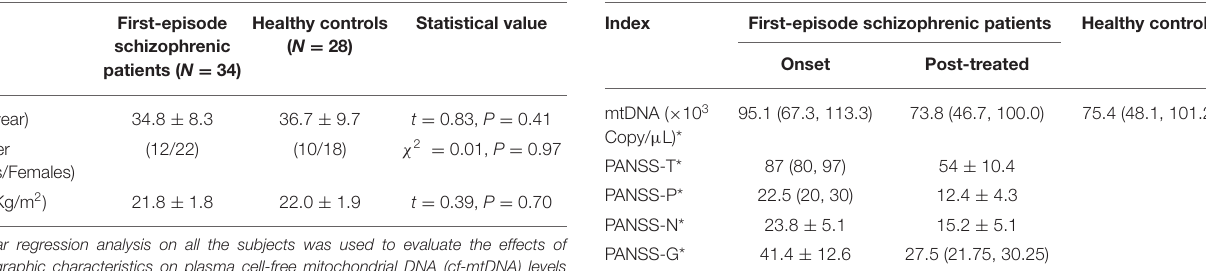
TABLE 2 | Plasma cf-mtDNA detection and the Positive and Negative Syndrome Scale (PANSS) assessment of the subjects.